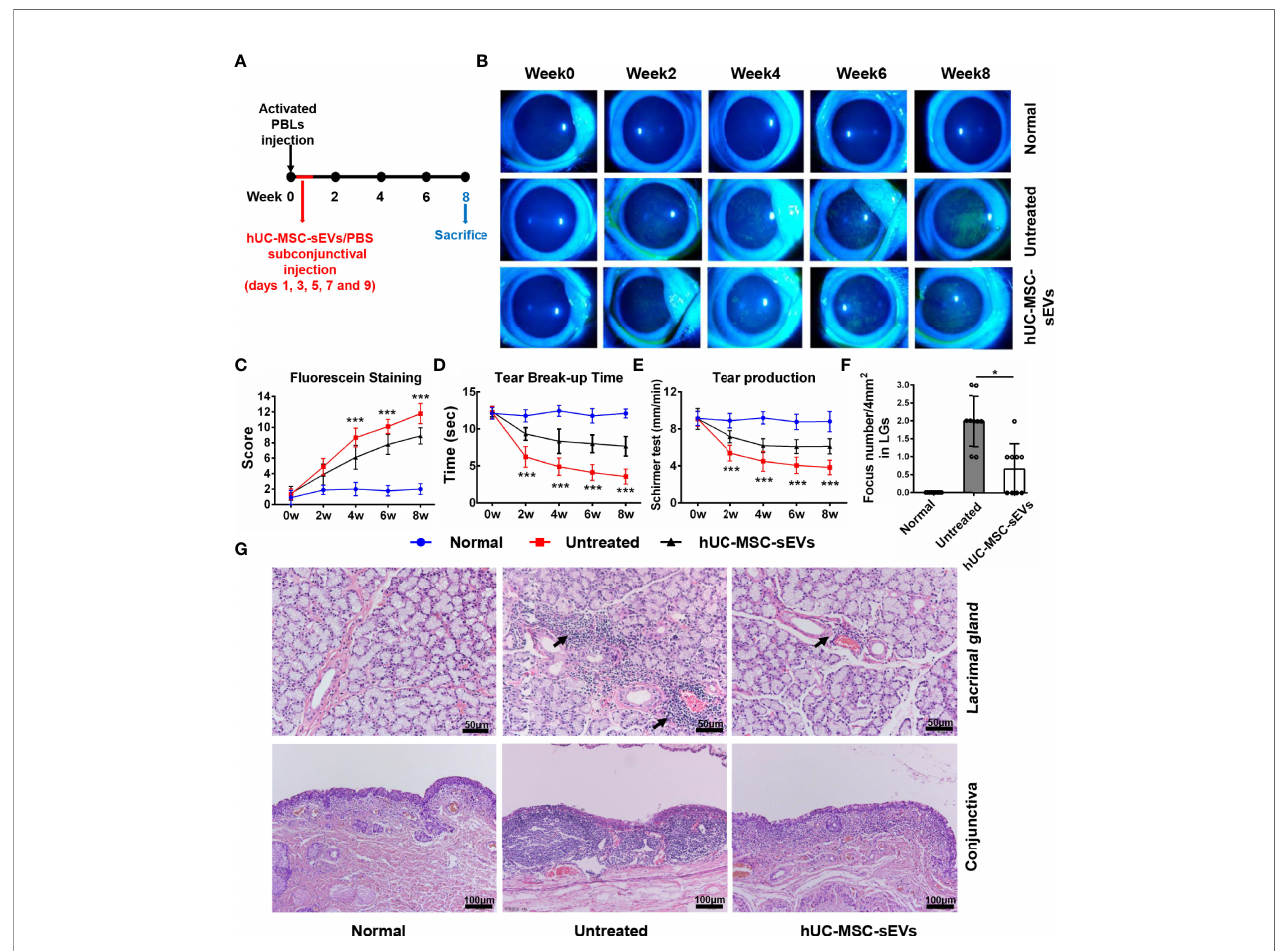
FIGURE 2 | The preventive effects of hUC-MSC-sEVs on rabbit autoimmune dacryoadenitis. (A) Schematic diagram of hUC-MSC-sEVs administered at the early stage of rabbit autoimmune dacryoadenitis. (B, C) Representative images and scores of fl uorescein staining in cornea. (D) The mean values of tear break-up time. (E) Quanti fi cation of tear production by Schirmer ’ s test. (F) Quanti fi cation of the numbers of lymphocytic foci per 4mm 2 in LGs. (G) Representative photographs of H&E staining in LGs and conjunctivas. Arrows indicate in fi ltrating lymphocytes. n = 9 rabbits per group (C – F) . Data were shown as mean± SD. * hUC-MSC-sEVs group versus untreated group, *P < 0.05, **P < 0.01, ***P <